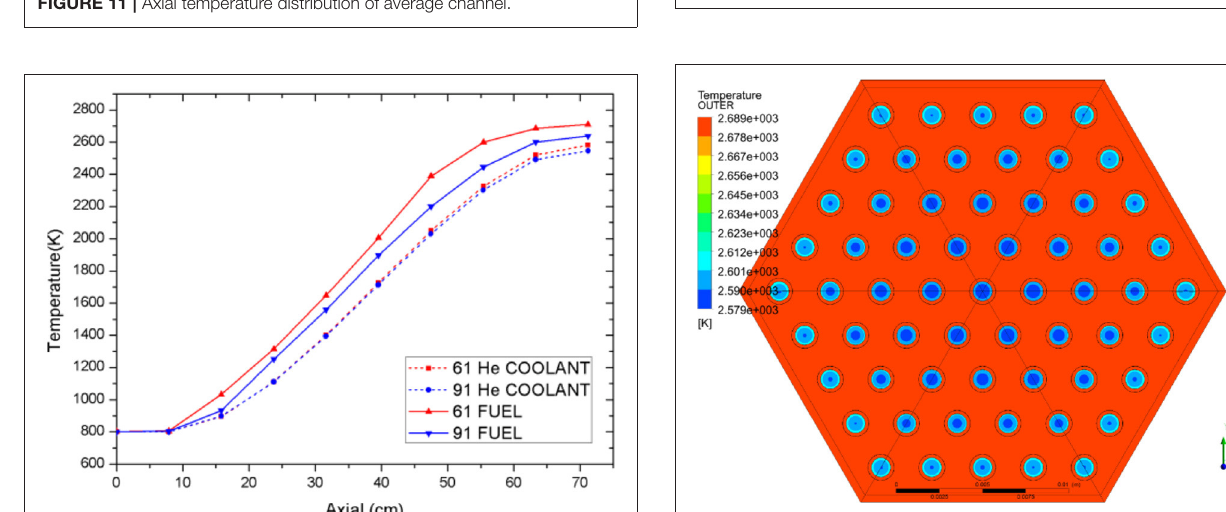
FIGURE 11 | Axial temperature distribution of average channel.